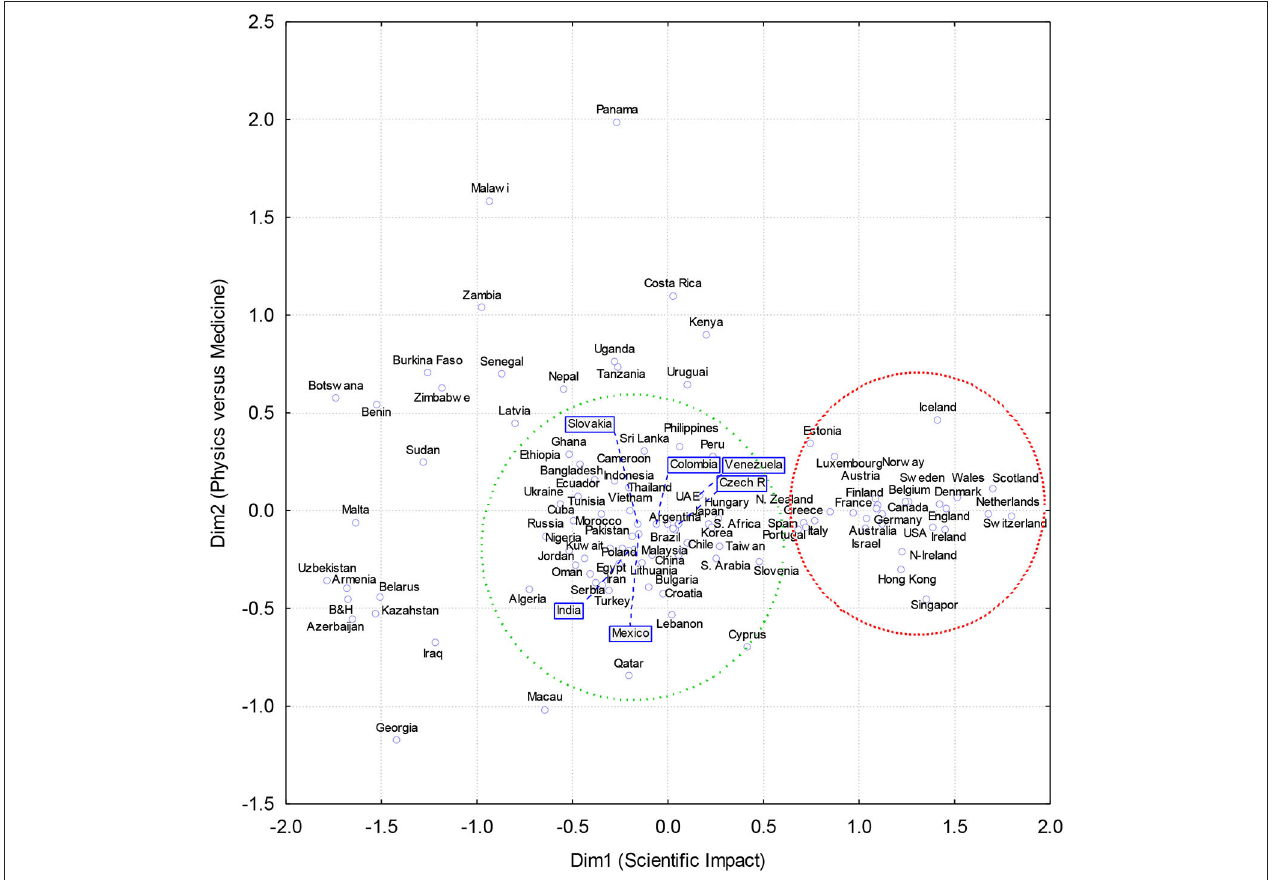
FIGURE 2 | Two-dimensional plot of a non-metric Guttman-Lingoes multidimensional scaling analysis of country’s citation profile similarities (Manhattan or City Block metrics of the normalized citation